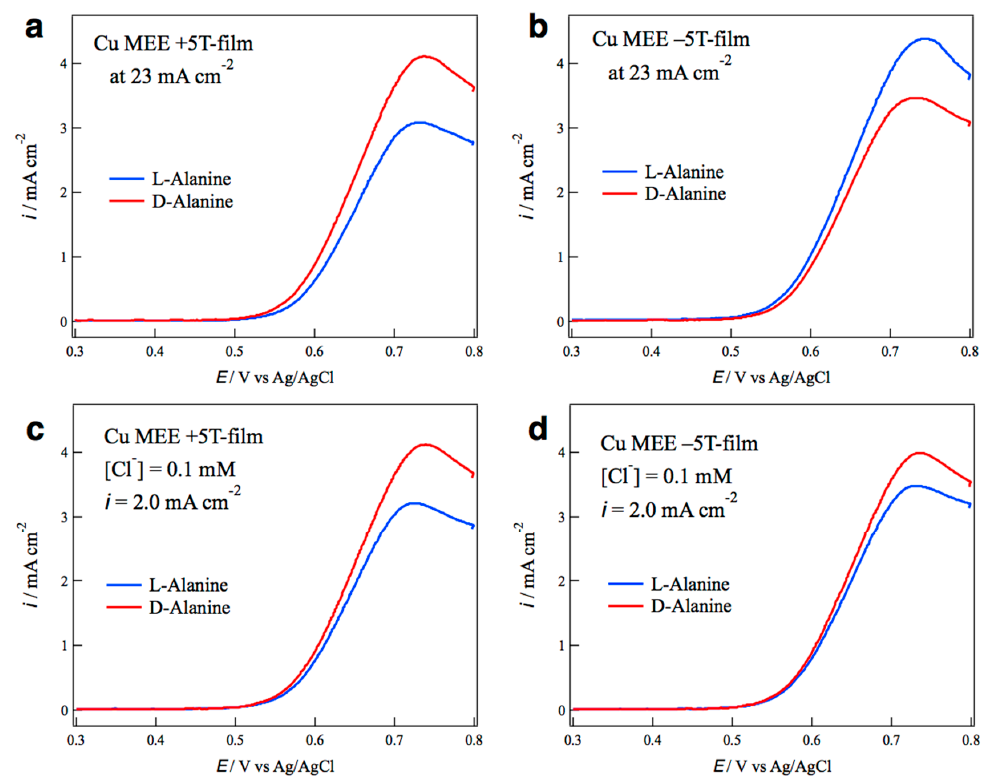
Figure 3. Chiral behaviors of the MEE film electrodes for the oxidation of alanine enantiomers. ( a ) +5T-film prepared at a deposition current of 23 mA · cm − 2 without KCl; ( b ) − 5T-film at 23 mA · cm − 2 without KCl; ( c ) +5T-film at 20 mA · cm − 2 with 0.1 mM KCl; and ( d ) − 5T-film at 20 mA · cm − 2 with 0.1 mM KCl.